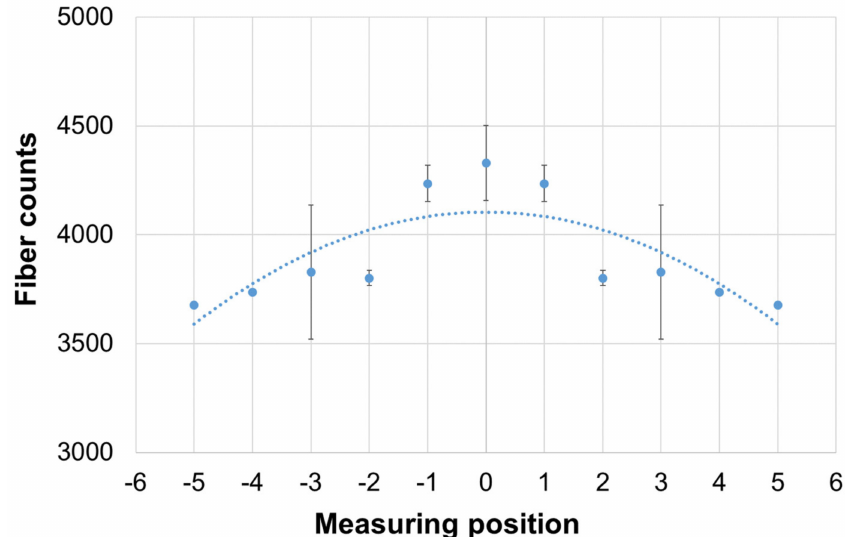
Figure 4. Fiber numbers determined by dynamic image analysis in correlation to the measuring position of the cuvette on horizontal axis. Fiber counts of position − 4 and − 5 are calculated values. A symmetric fiber distribution was assumed, and a quadratic curve fitting was applied.